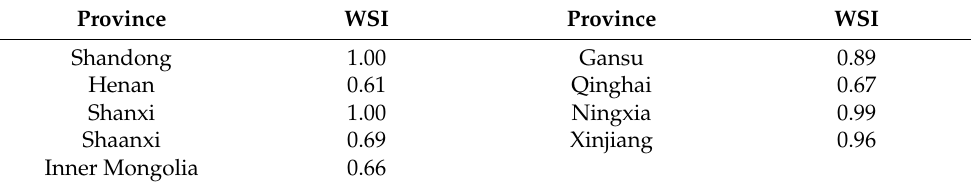
Table 4. Water stress index of each province in the Yellow River Economic Belt.